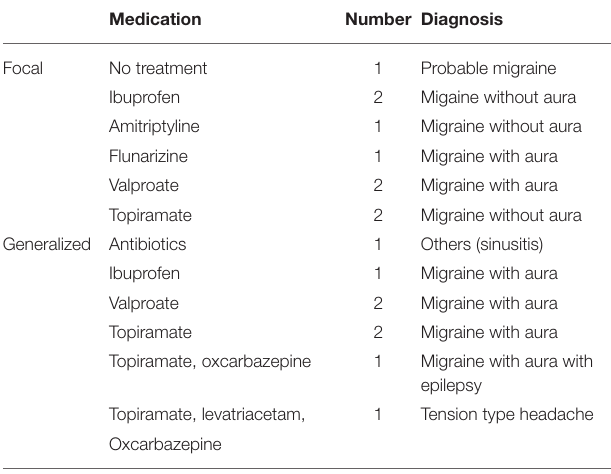
TABLE 5 | Acute and preventive medication of headache patients with epileptiform P -value Normal Abnormal ( n = 228) ( n = 31)